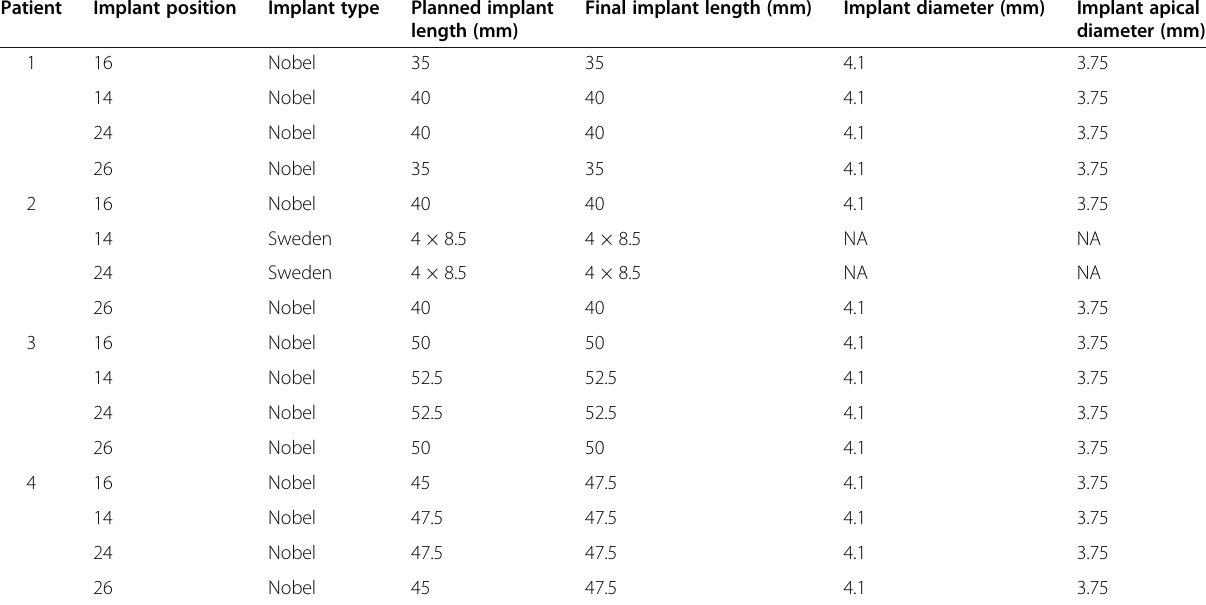
Table 1 Sample characteristics